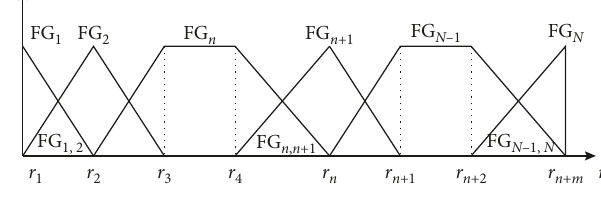
Figure 2: Fuzzy risk grade.